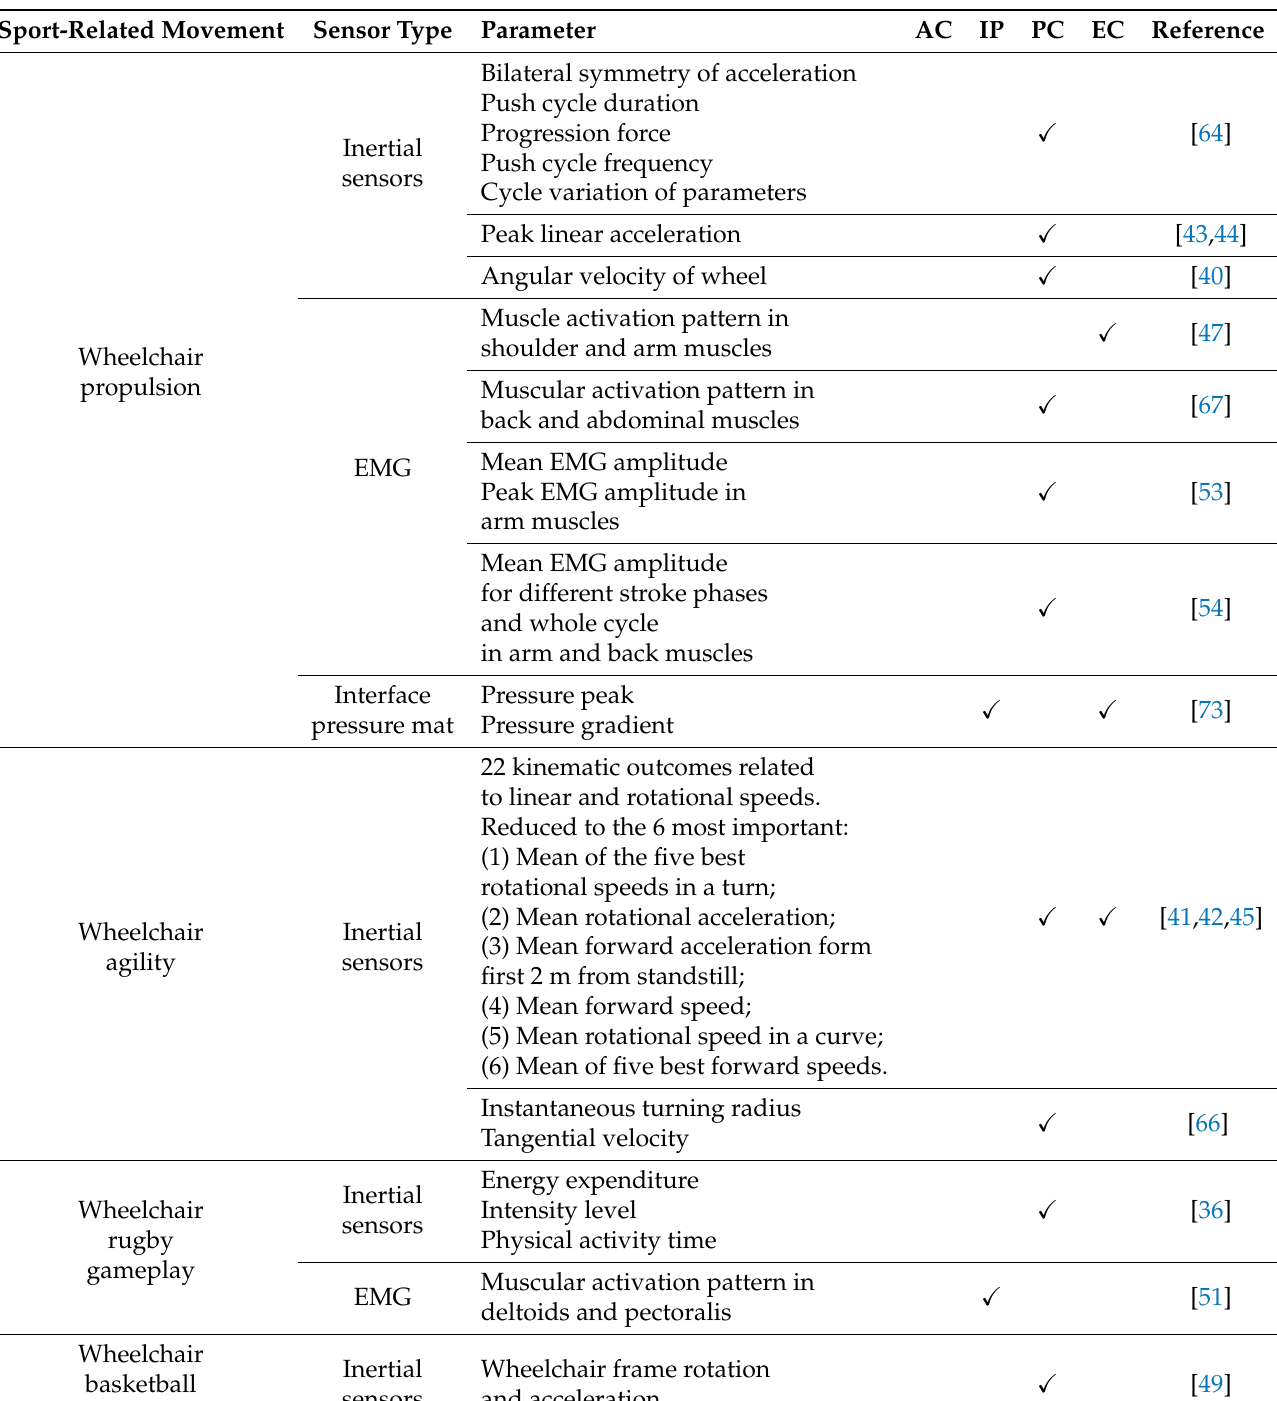
Table 3. Parameters measured with wearable sensors in sport for disabled people and the applications where the parameters have been used. AC = Athlete Classification; IP = Injury Prevention; PC = Performance Characterization; EC = Equipment